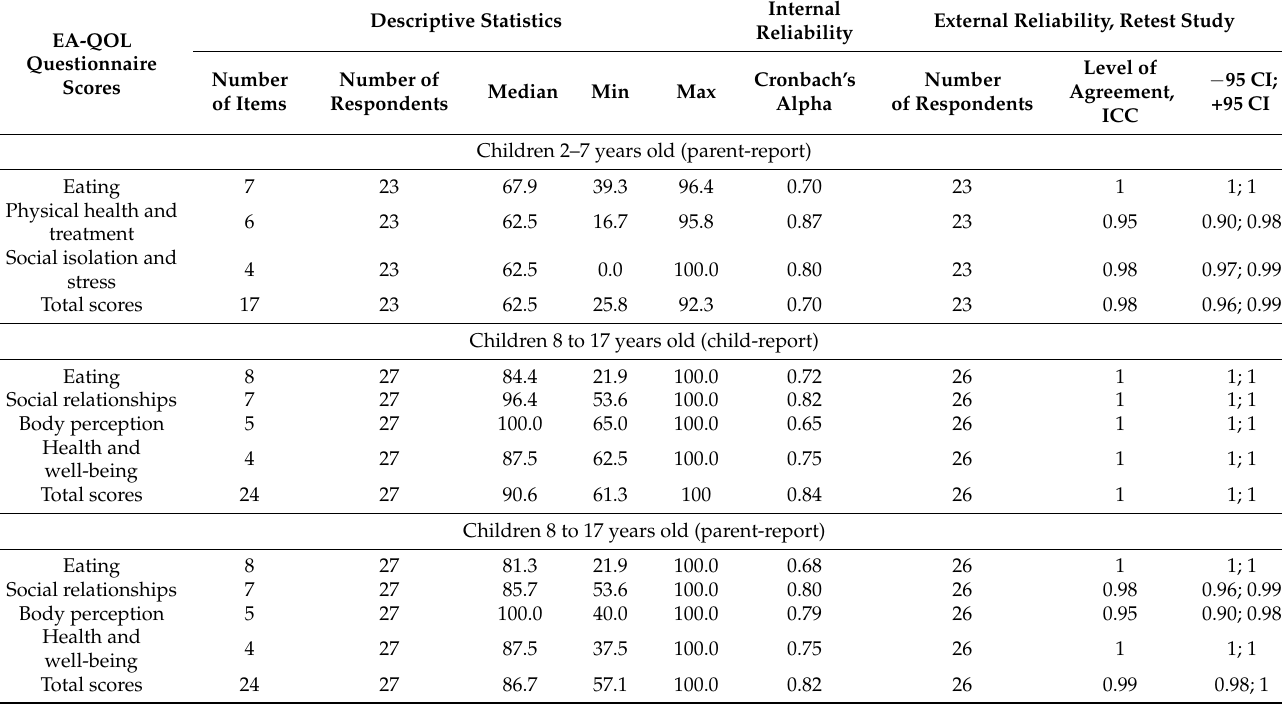
Table 3. Descriptive statistics, internal consistency, and external reliability of the EA-QOL- questionnaire for children aged 2 to 7 years (parent-report) and children aged 8 to 17 years (child- and